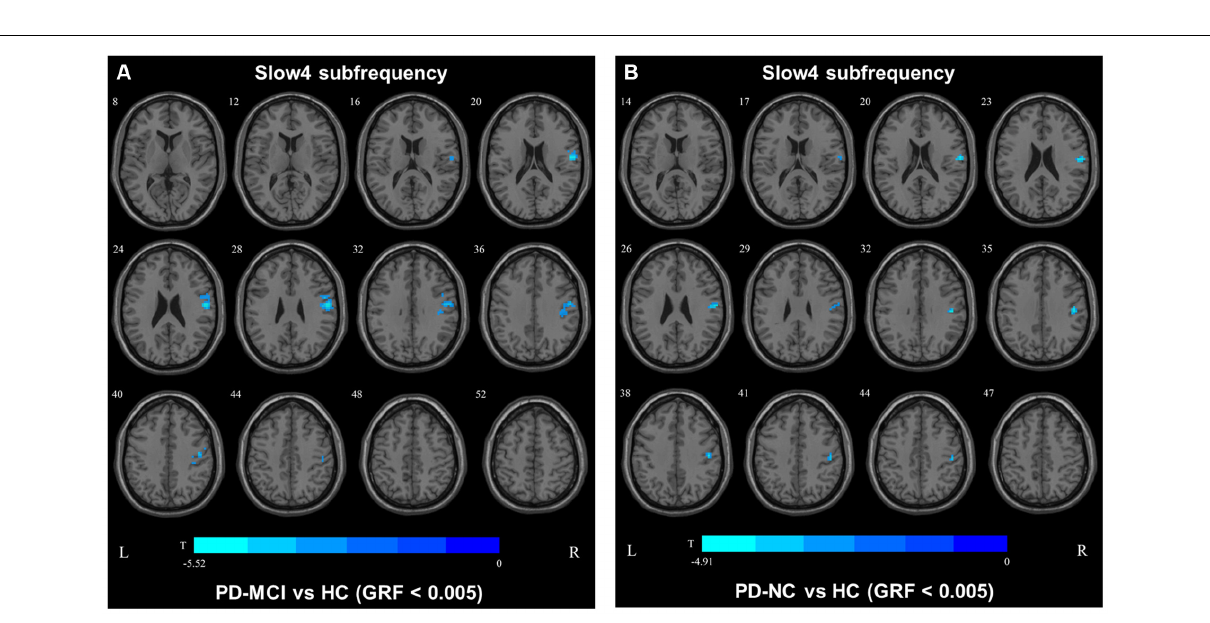
FIGURE 5 | fALFF map differences among the groups in slow4 subfrequency band. The fALFF results were compared by two sample t -tests (GRF corrected, voxel p < 0.005, cluster p < 0.05). The color bar on the bottom indicates the statistical t value. The cold color indicates a significantly decreased fALFF in the comparison. Additional details regarding these regions with difference are shown in Table 3 . (A) Decreased fALFF in PD-MCI patients between PD-MCI and HC. (B) Decreased fALFF in PD-NC patients between PD-NC and